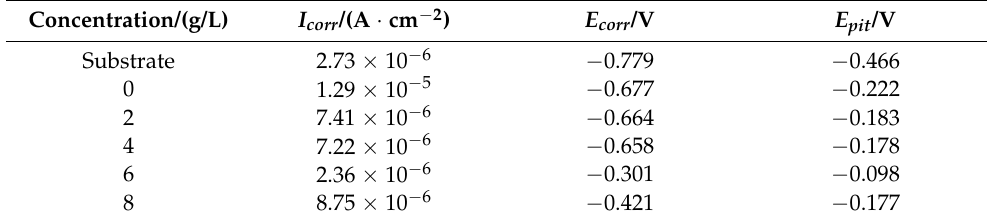
Table 2. Tafel fitting results of polarization curves of Cu-Ni-ZnO nanocomposite coatings with dif- ferent (Cu, Ni)-ZnO additions.